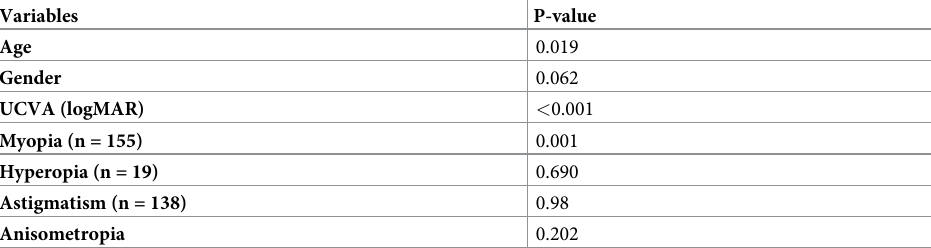
Table 3. Logistic regression analysis of the presence (n = 108) and failure (n = 87) of fusion in the W4d test and clinical variables (N = 195).